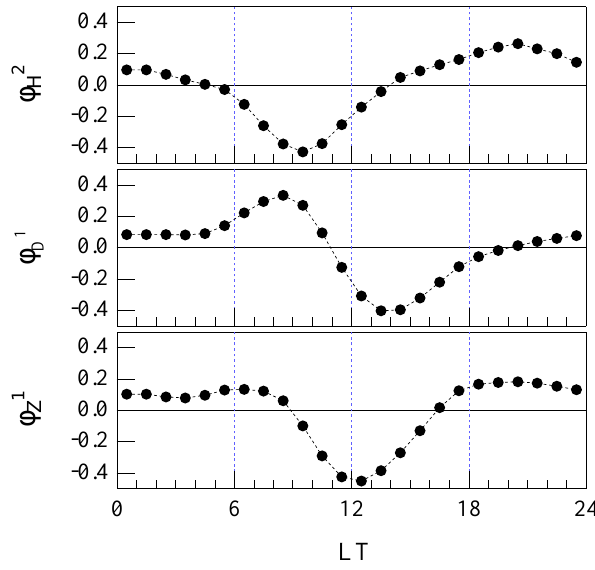
Fig. 2. The NOC eigenvalue spectra λ k of H, D and Z magnetic field elements. The λ k spectra of declination D has been scaled by a factor 10 3 for convenience. The dashed lines are exponential fits of spectra in the range k ∈ [ 10 , 21 ] characterized by a characteristic decay factor α =[ 0 . 148 ± 0 . 006 ] .